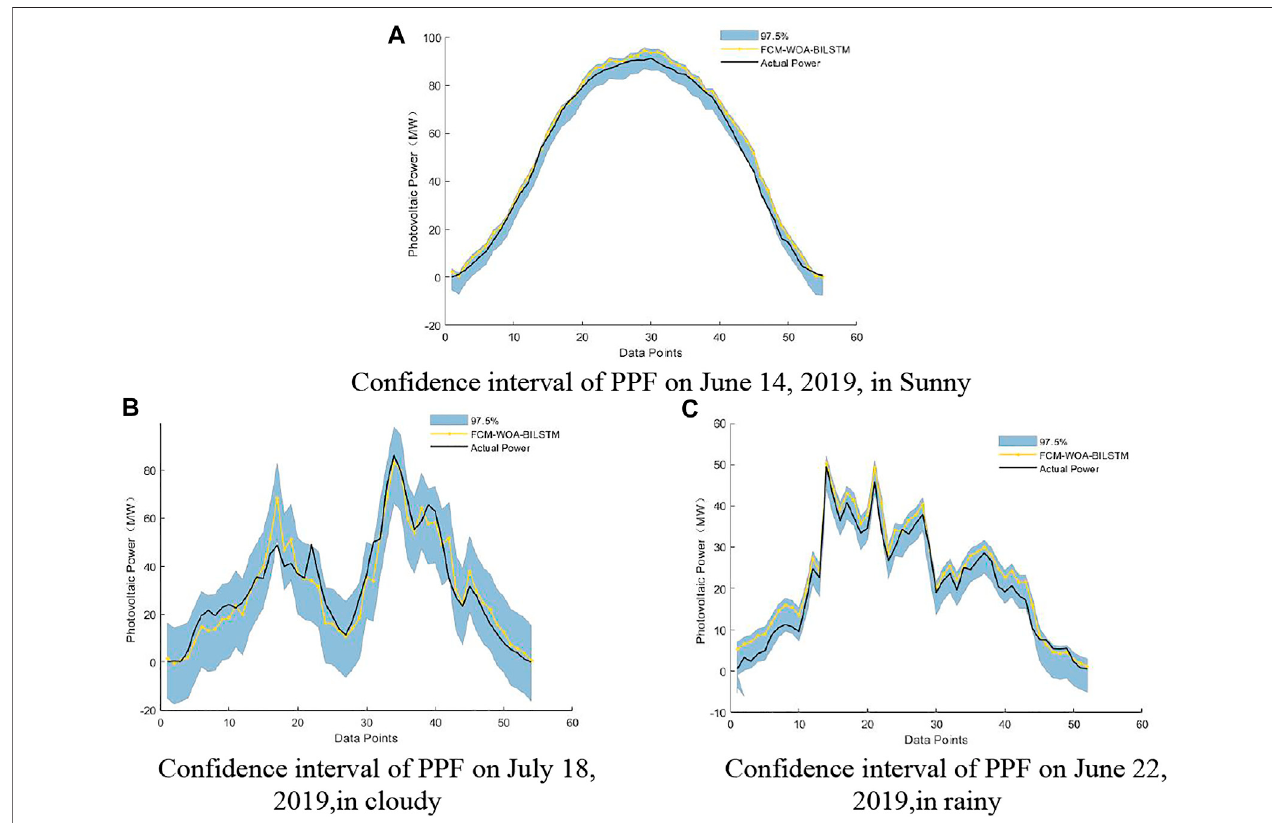
FIGURE 12 | 97.5% Con fi dence interval of PPF under different climatic